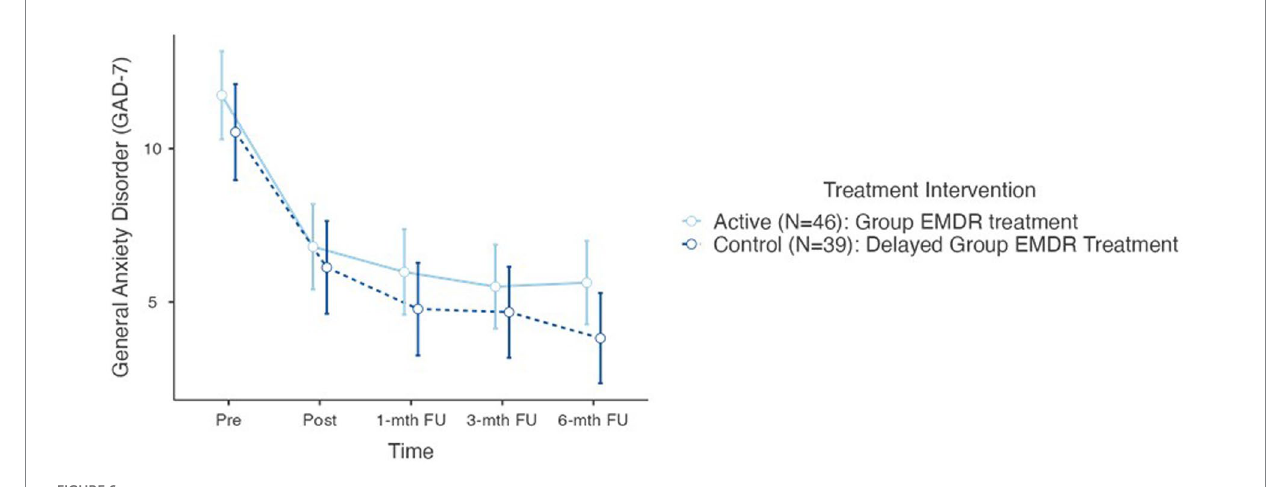
FIGURE 6 GAD-7 psychometric scores for active and control groups (total N =85).